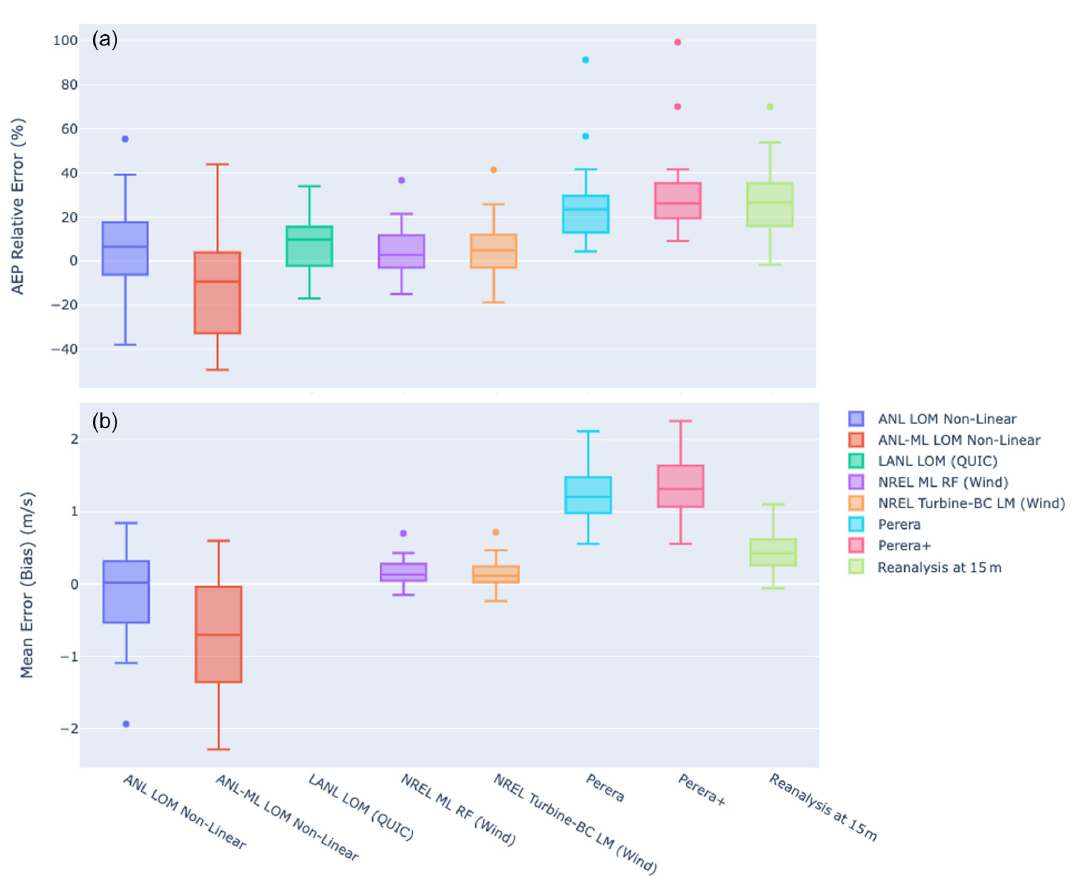
Figure 10. Box and whisker plots showing performance (median, IQR, 90th percentiles, and outliers) for the models studied for annual production estimate relative error (a) and mean pointwise wind speed bias (b)